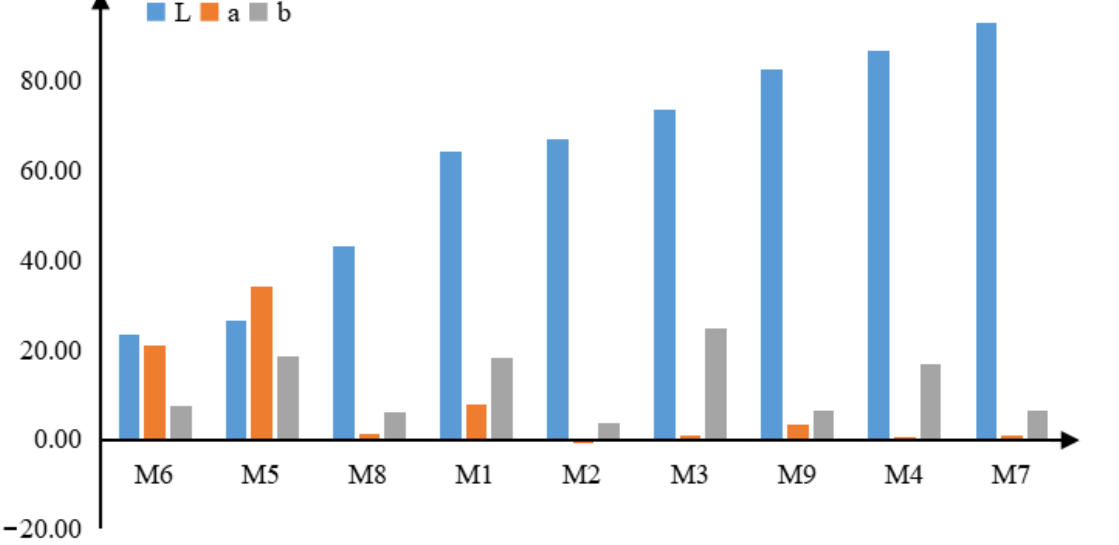
Figure 10. Material surface colour value (M1: Joinery board, M2: PVC board, M3: Fireproof board, M4: Solid wood board, M5: Painted solid wood board, M6: Melamine board, M7: Painted board, M8: Blister board, M9: Quartz board).